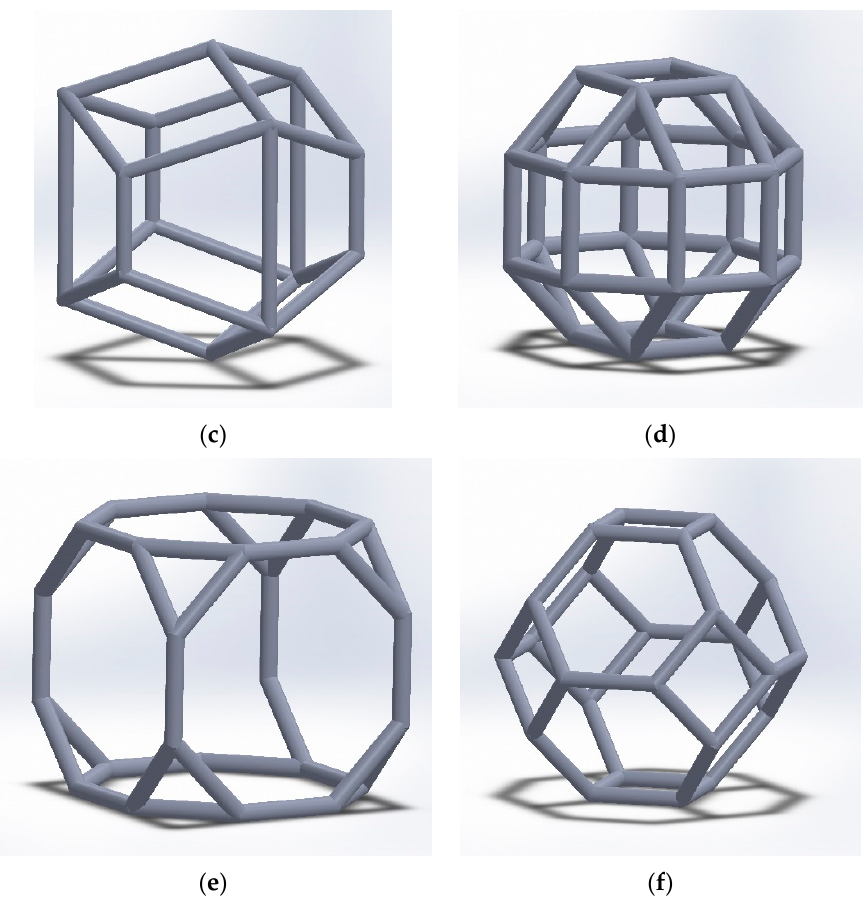
Figure 4. Unit cells of ( a ) body-centred cubic (BCC), ( b ) diamond, ( c ) hexagonal packing, ( d ) rhom- bicuboctahedron, ( e ) truncated cube, and ( f ) truncated octahedron.